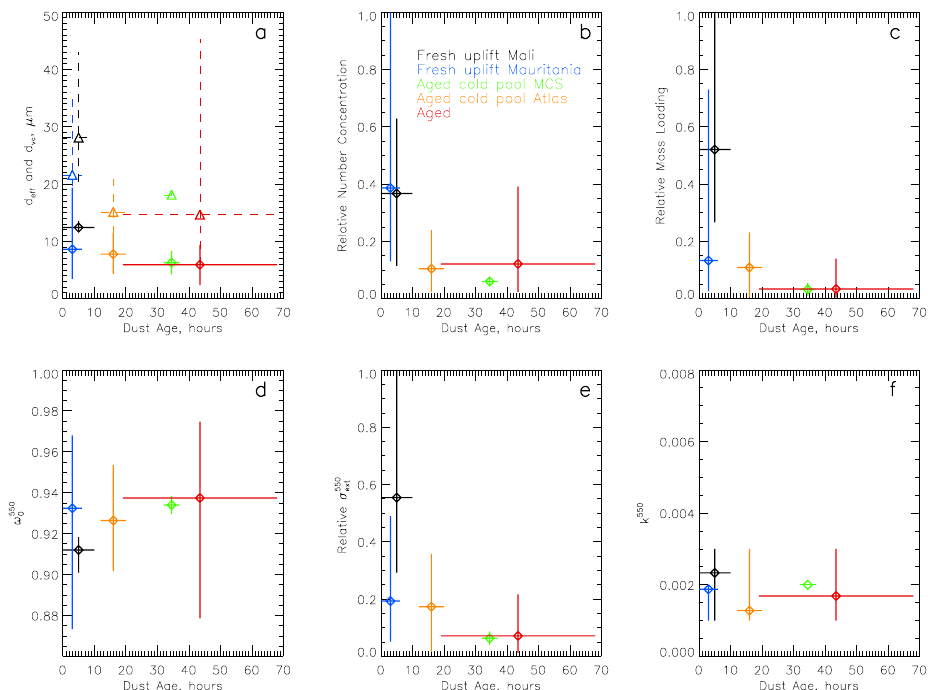
Fig. 11. Relationship between dust age since uplift and (a) deff (solid lines and diamonds) and dvc (dashed lines and triangles); (b) relative total number concentration; (c) relative mass loading; (d) ω 550 ; (e) relative σ 550 ext and (f) accumulation mode k 550 . Horizontal and vertical 0 lines represent the range of values observed in each category, data points represent the mean. Events are categorised as described in the text covering fresh dust uplifted in Mali (black), fresh dust uplifted in Mauritania (blue), aged dust uplifted by an MCS over Mali (green), aged dust uplifted by a cold pool originating over the Atlas Mountains (yellow), and aged dust uplifted over central Algeria (red). All parameters apart from k550 represent the full size